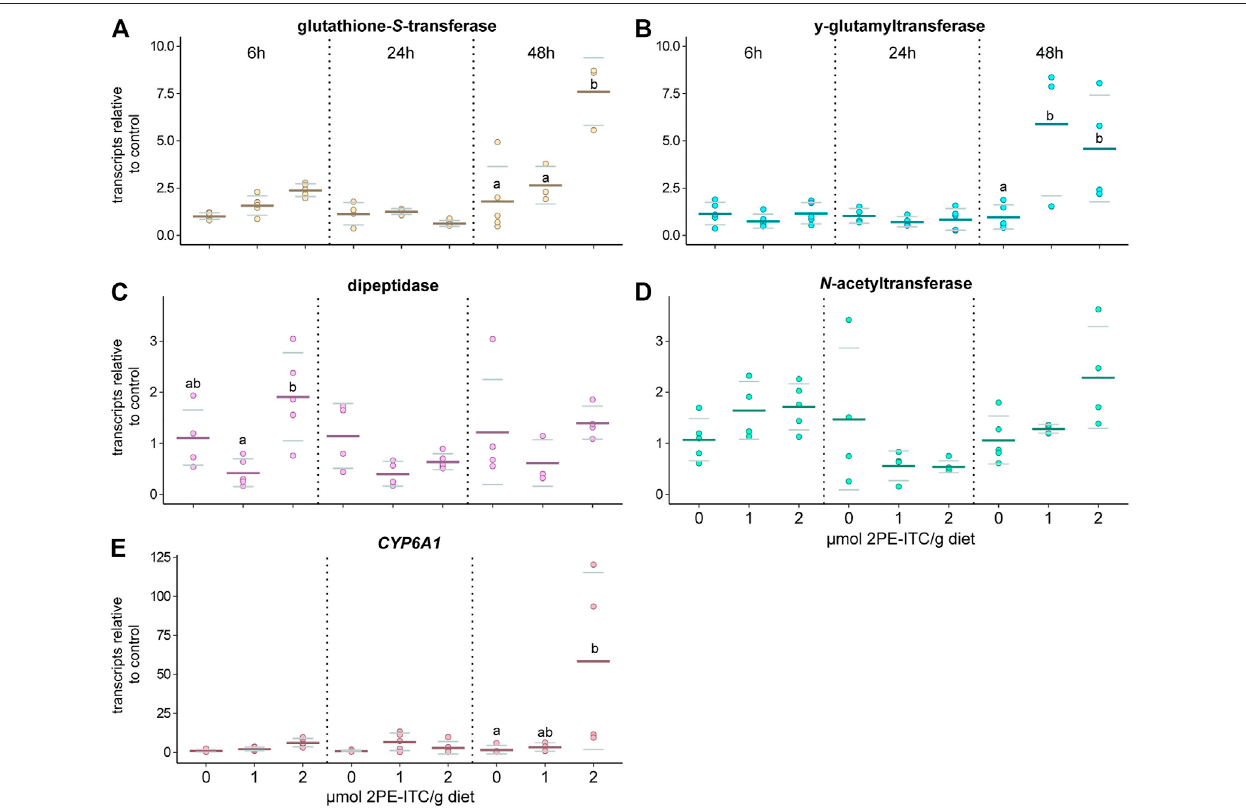
FIGURE 5 | Expression of selected candidate genes related to the mercapturic acid pathway (A – D) and cytochrome P450 (CYP6A1, E) responding to 2- phenylethyl isothiocyanate (2PE-ITC) in D. radicum larvae measured by qPCR. Larvae were fed on 0, 1 or 2 µmol 2PE-ITC/g diet for 6, 24 and 48 h and the response of transcriptsofacandidate genecoding forglutathione- S -transferase (A) , γ -glutamyltransferase (B) ,dipeptidase (C) , N -acetyltransferase (D) and CYP6A1 (E) compared relativetothecontrolsampleusing2 − ΔΔ Ct .Meanvalueswerepresentedasdarklines,standarddeviationasgreylinesandindividualvaluesasdots.Differentletters indicate signi fi cant differences between the treatments of one timepoint with a p -value < 0.05 using two-way ANOVA followed by Tukey post-hoc test.